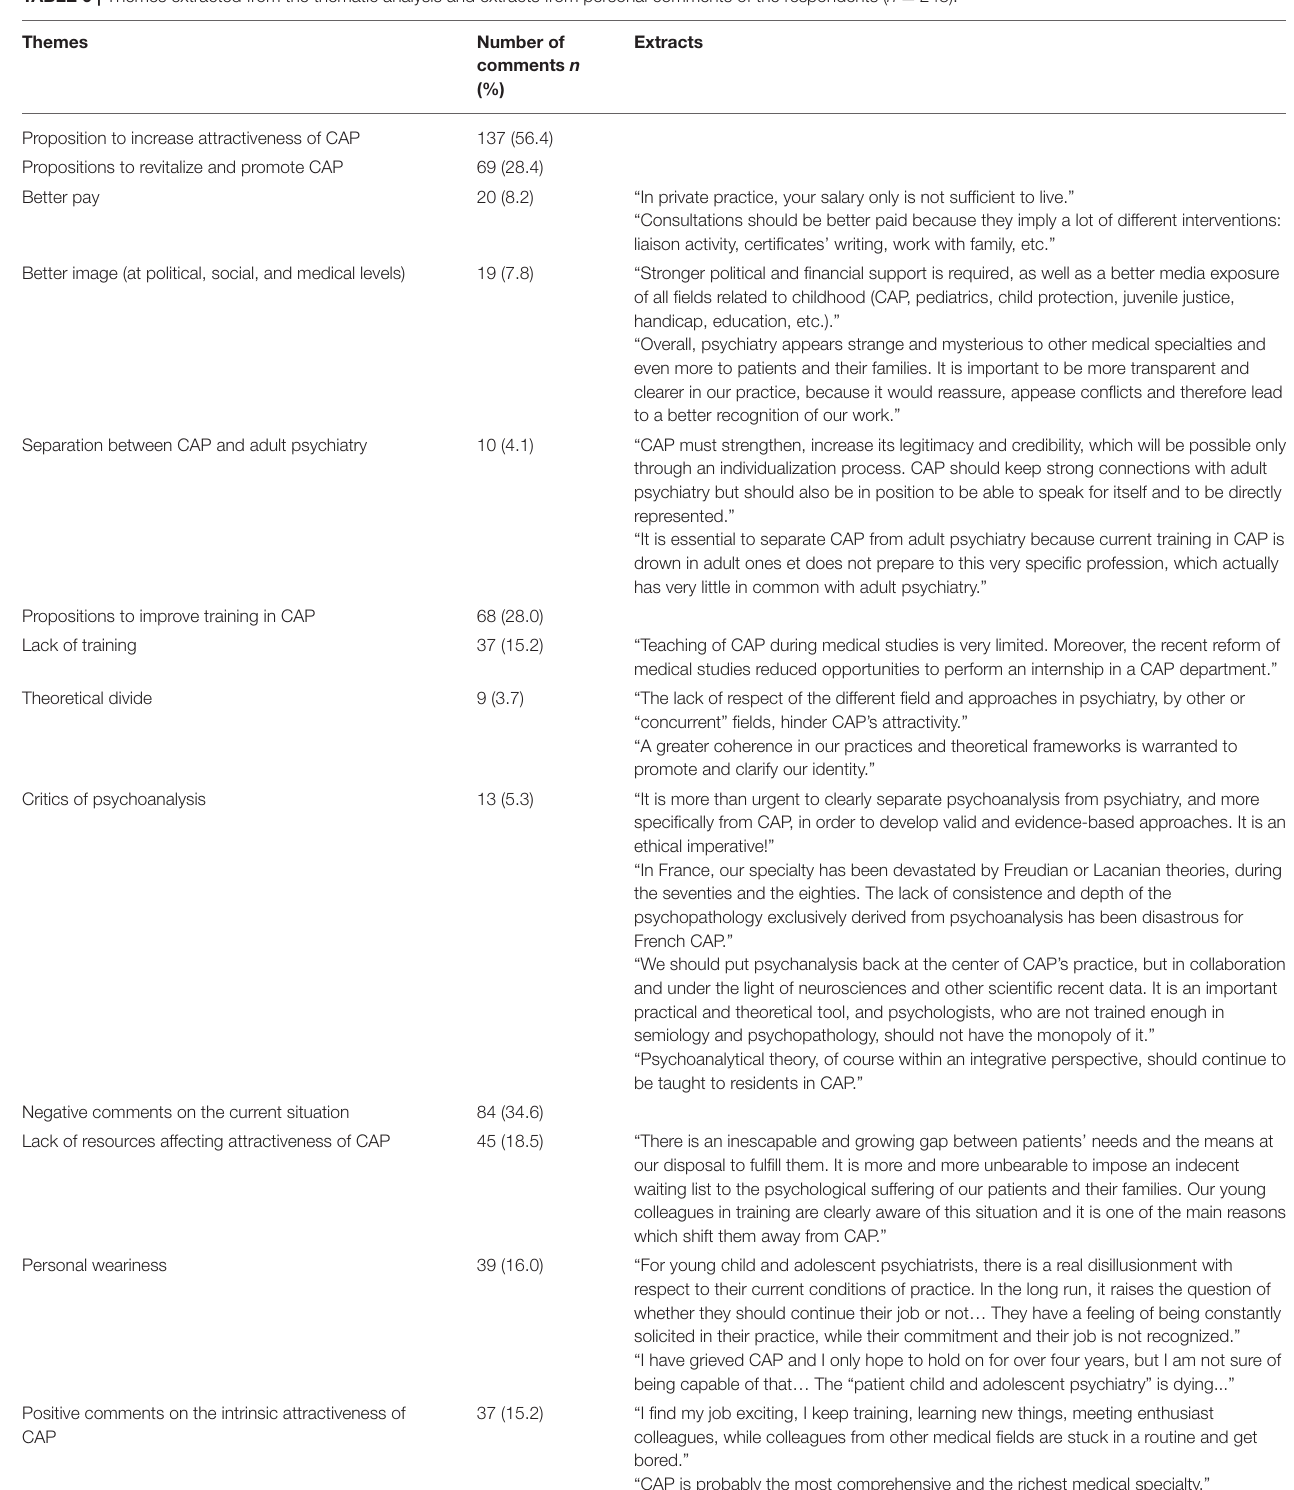
TABLE 6 | Themes extracted from the thematic analysis and extracts from personal comments of the respondents ( n =